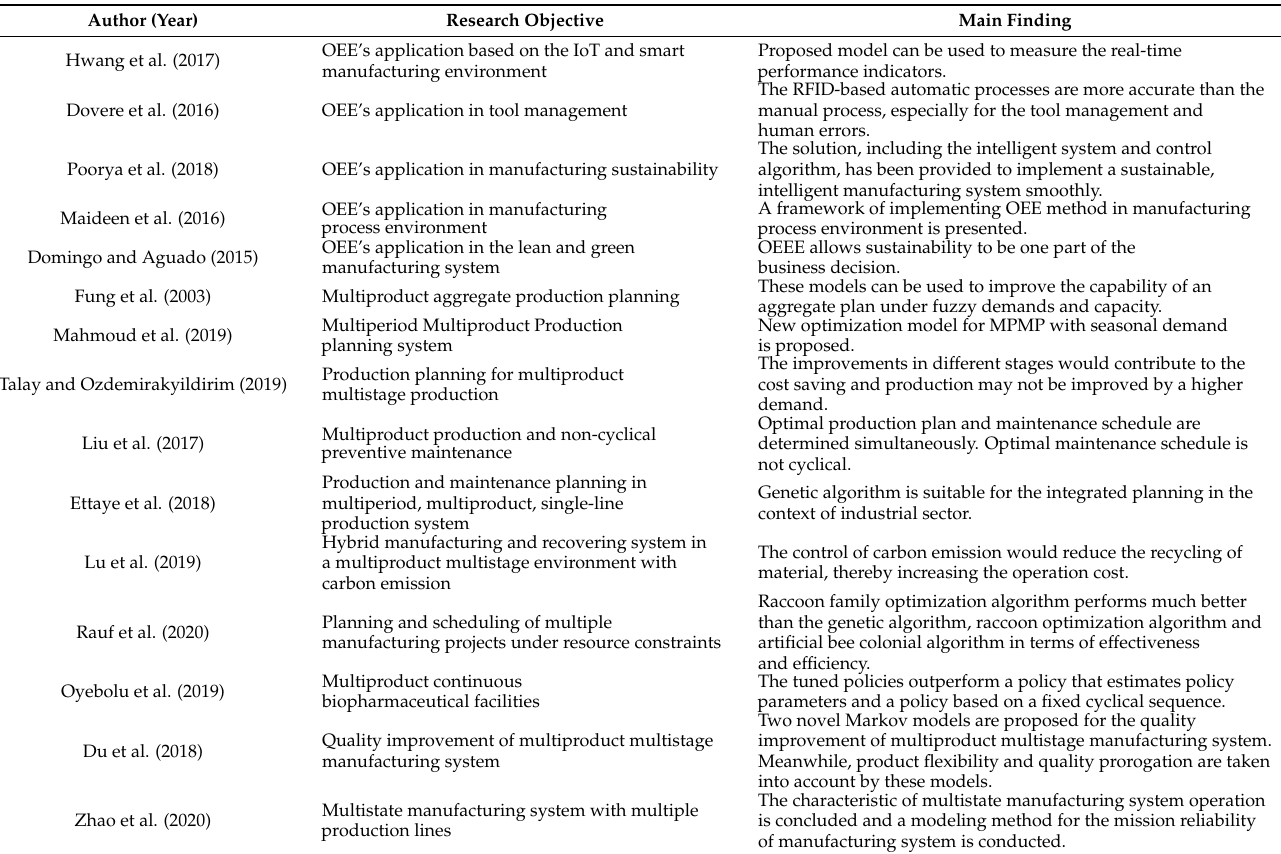
Table 1. Literature review about Overall Equipment Effectiveness (OEE) application and the multiproduct production